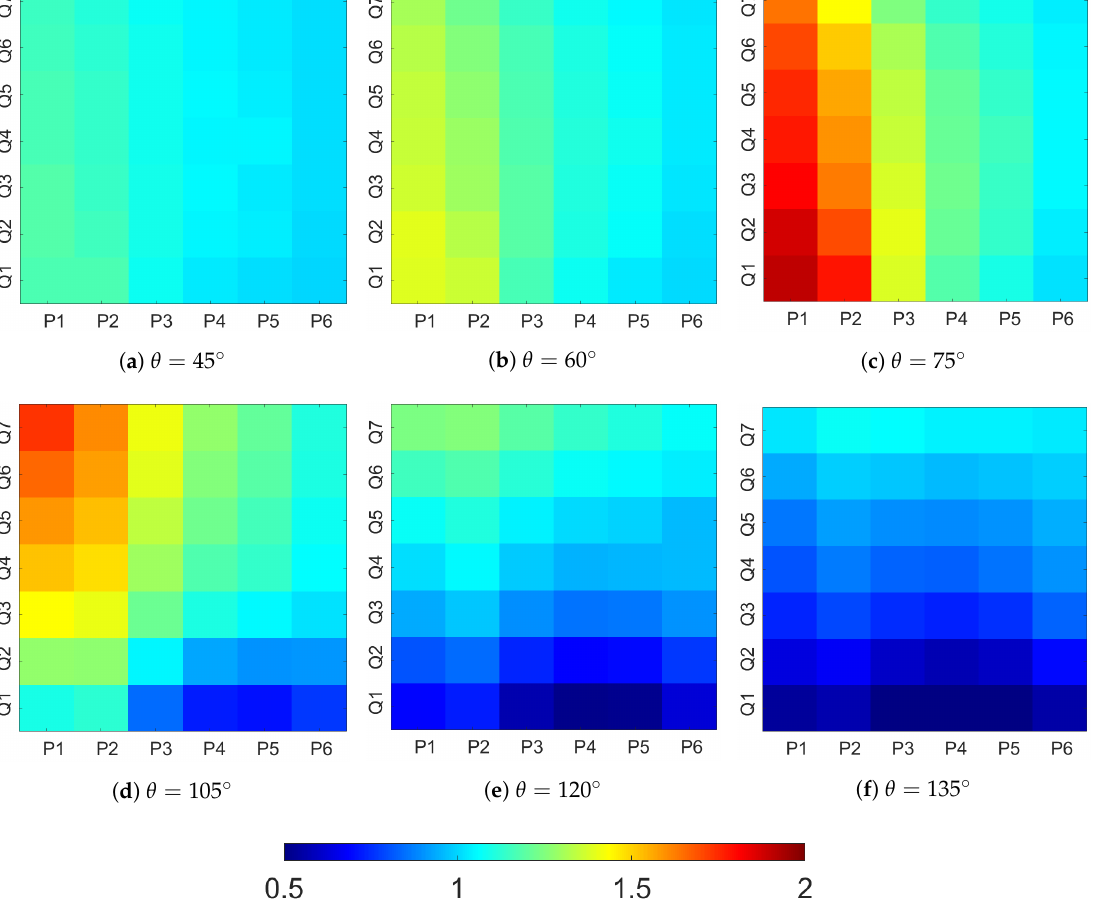
Figure 10. Improvement factors for all flowing